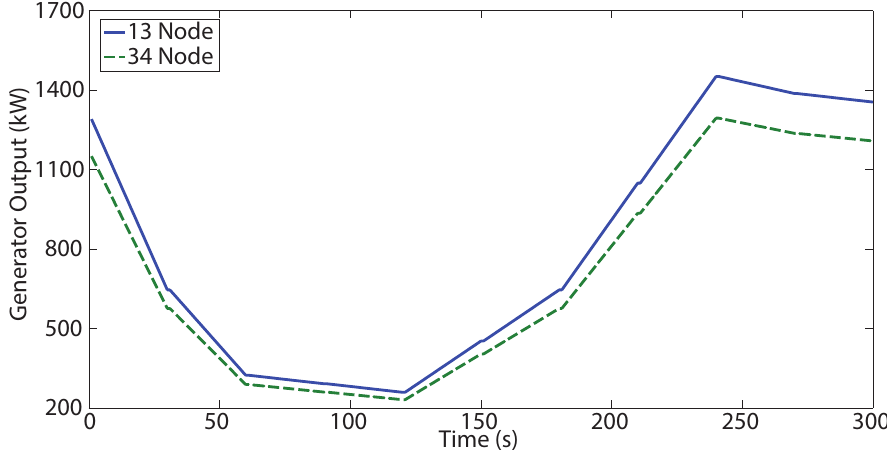
Figure 6. The assumed output power of the wind